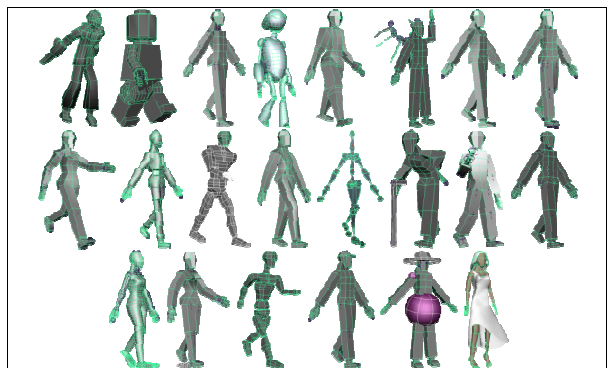
Figure 9. Robot Manikins Created by